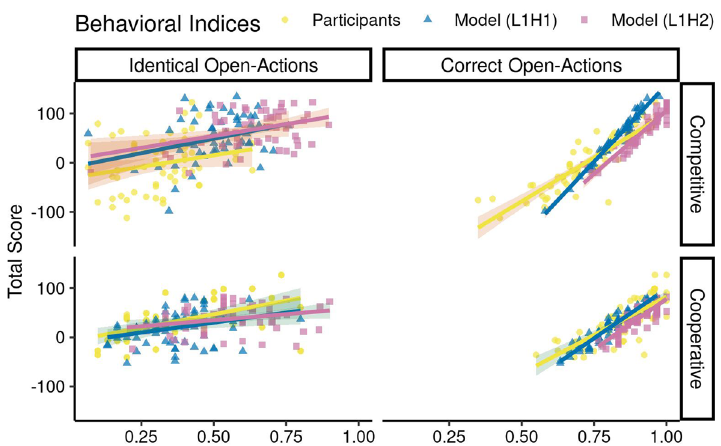
Figure 10. Linear mixed-effects regression model comparison between the participants and the two IPOMDP models. Correct open-actions and identical open-actions have significant effect on the total score in both